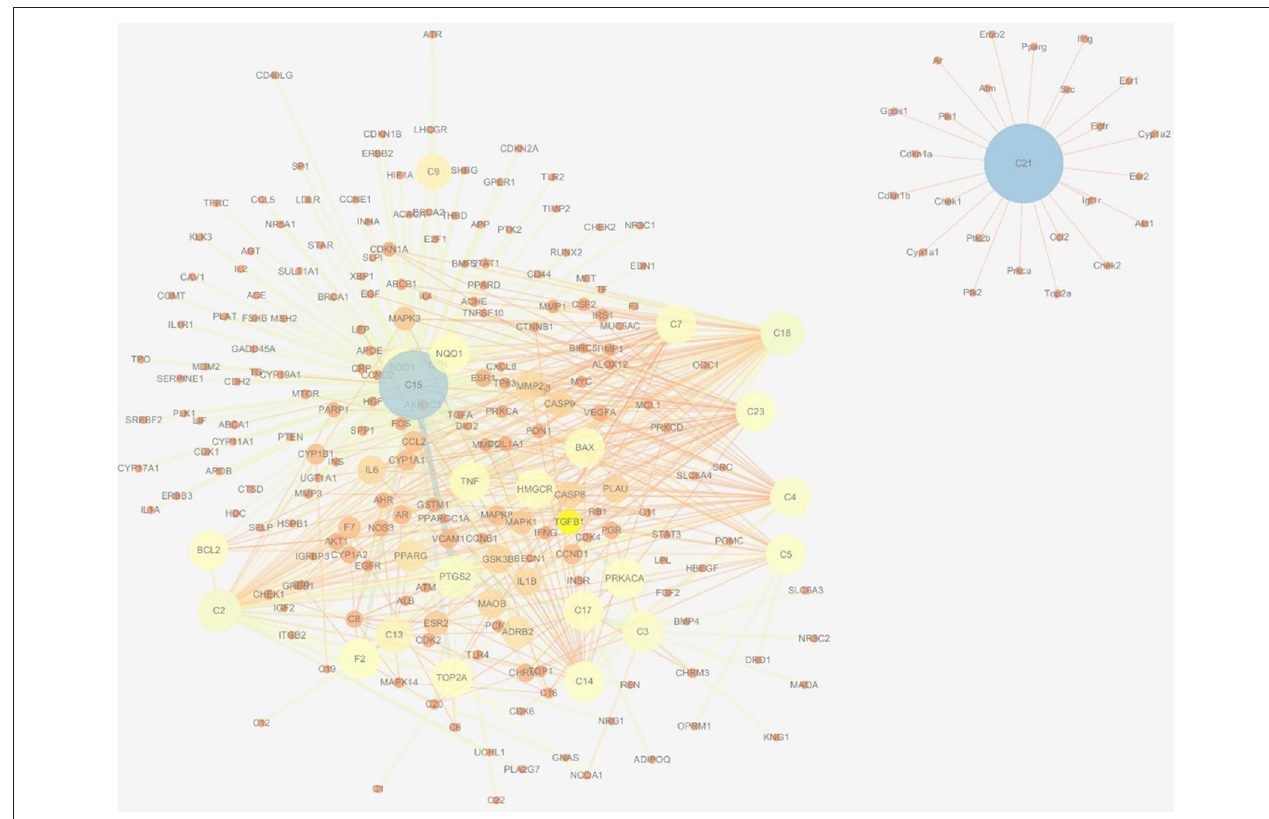
FIGURE 4 | Therapeutic compound-target network of menopause and GJE. The size of nodes and edges is proportional to its value. The color brightness of the nodes is inversely related with its value. In other words, the value of the node is the highest when the color is blue, and the value of the node is the lowest when the color is